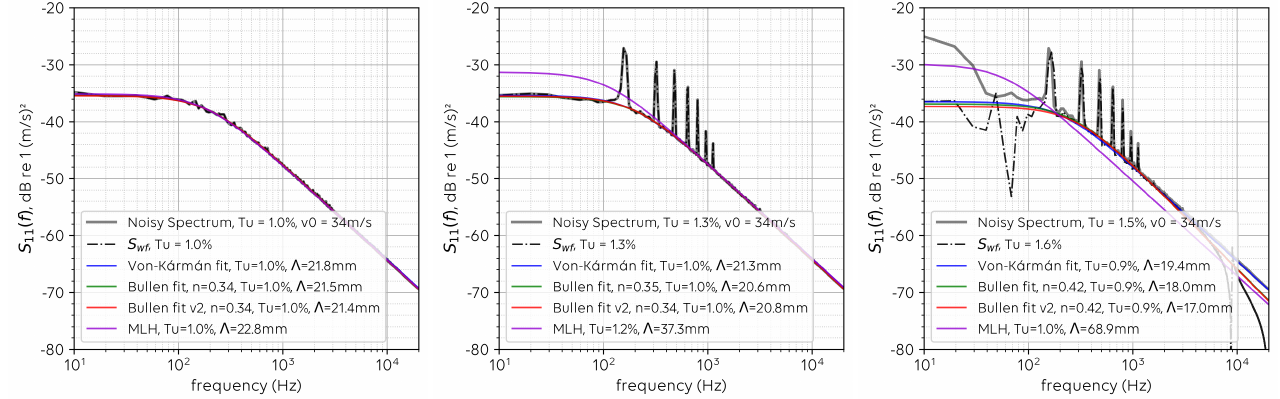
Figure 3. Synthetic turbulence spectra for the longitudinal velocity component. Parameters used: U 0 = 34 m/s, Tu = 1%, ILS = 20 mm. Different sources of noise are added, such as: white noise, synthetic tones and low frequency distortion. Parameter estimation results are plotted with different